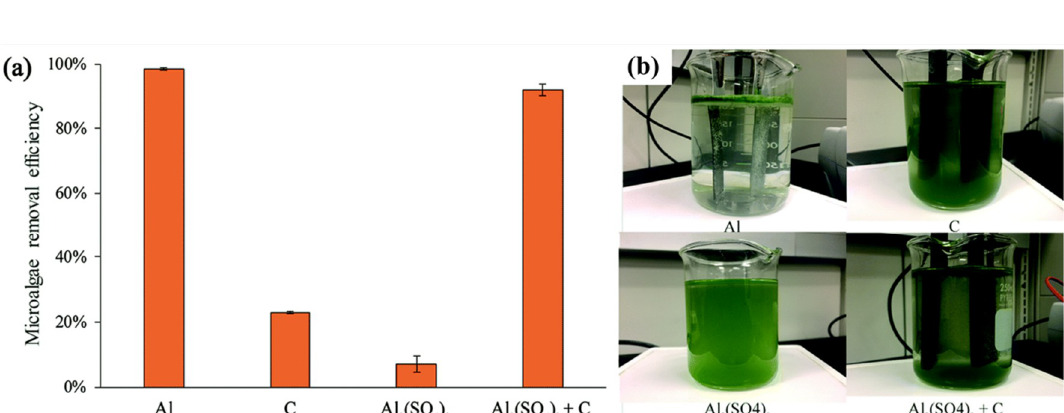
Figure 7. Electrochemical flocculation harvesting of microalgae using aluminum electrodes (Al), graphite electrodes (C), aluminum sulfate (Al 2 (SO 4 ) 3 ), and graphite electrodes with aluminum sulfate (Al 2 (SO4) 3 + C): ( a ) microalgae removal efficiency; and ( b ) photographs of the harvesting processes.